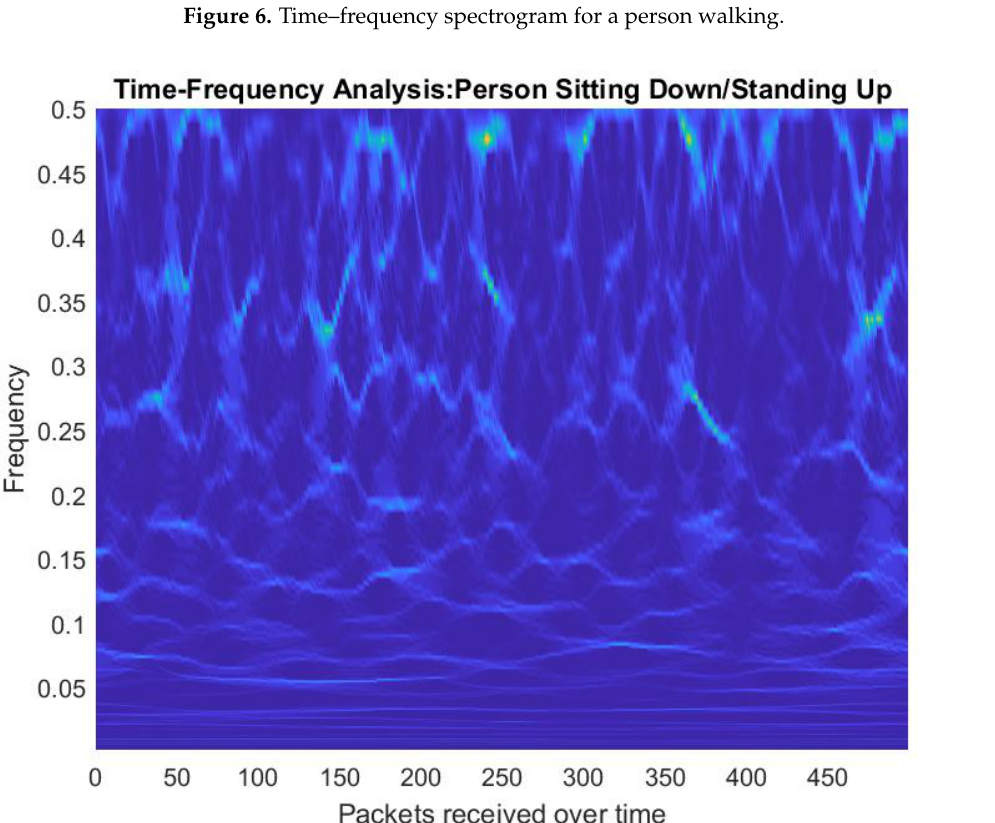
Figure 7. Time–frequency spectrogram for a person sitting down and standing